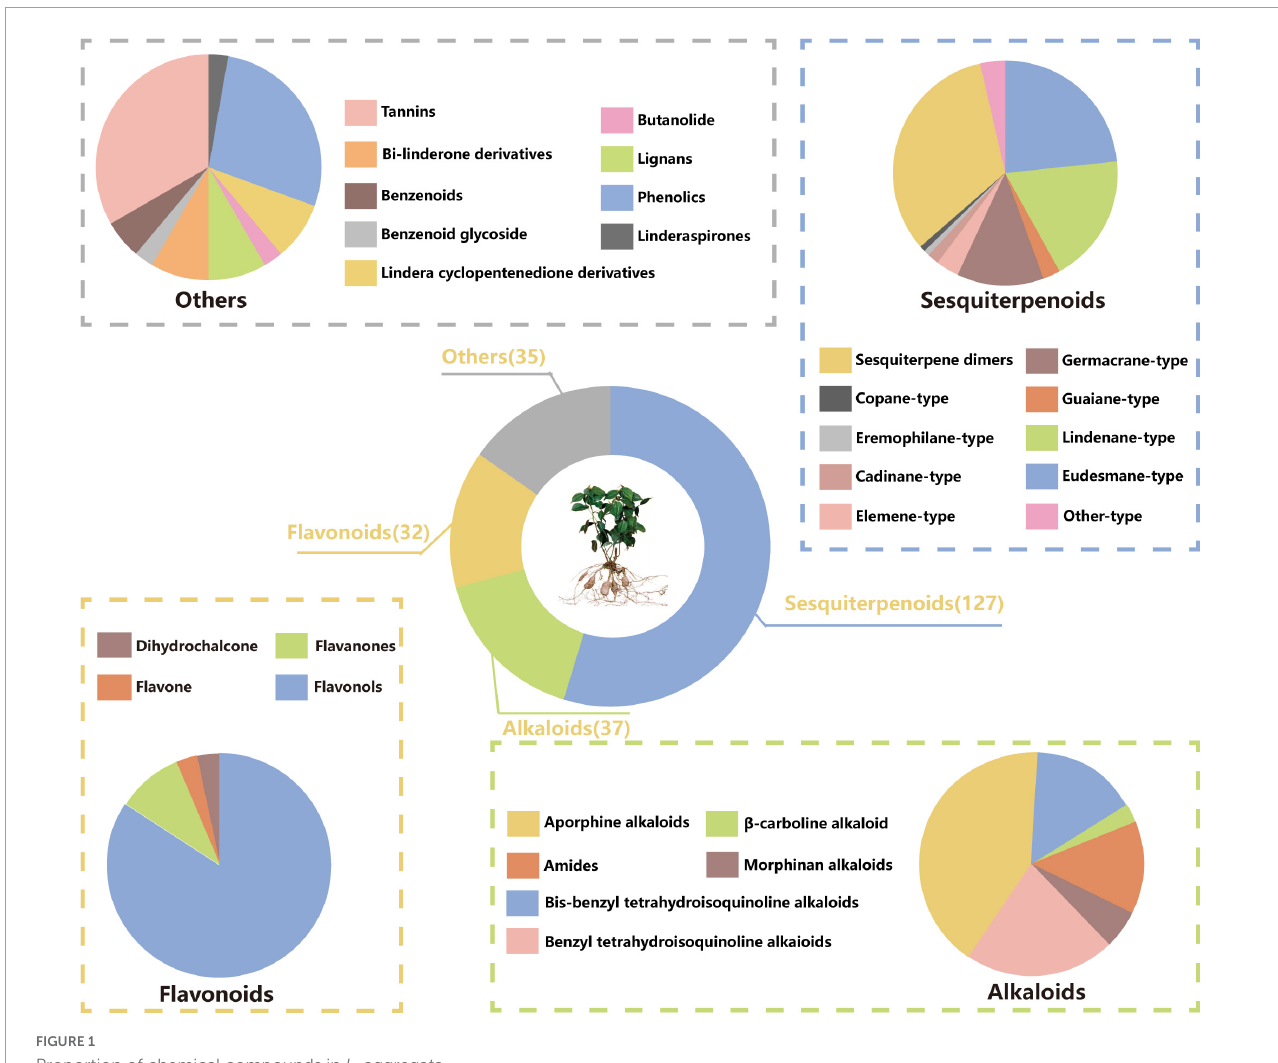
FIGURE1 Proportion of chemical compounds in L.